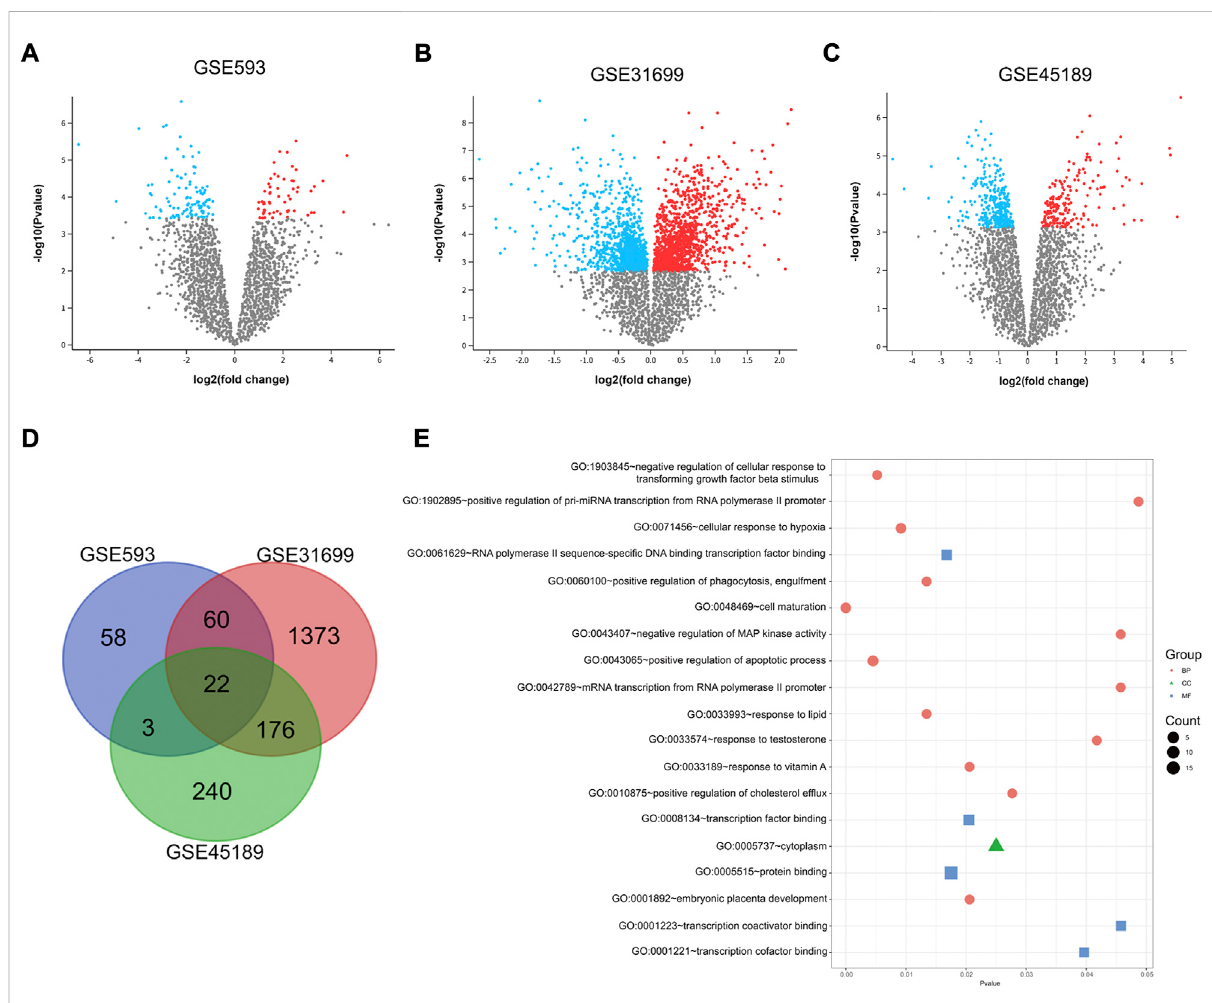
FIGURE 1 DEGs identi fi ed by GEO2R. Volcano plot of differentially expressed genes in GSE593 (A) , GSE31699 (B) , and GSE45189 (C) datasets. Up- regulation and down-regulation genes are marked with red and blue respectively. The criteria for a DEG are |log2FC| > 1 and adjusted p -value < 0.05. (D) Venn diagram based on the DEGs from all 3 datasets, 22 genes were extracted. (E) Gene Ontology Enrichment analysis of 22 DEGs. P < 0.05 was identi fi ed as the critical threshold for signi fi cant enrichment. MF, molecular function, CC, cell composition, BP, and biological